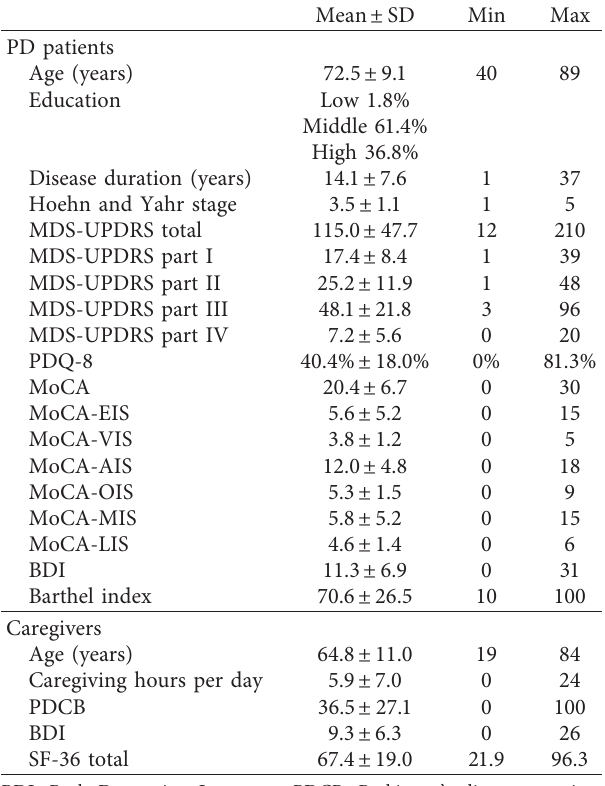
Table 1: Patient ( n � 124, 61 females) and caregiver ( n � 78, 42 females)